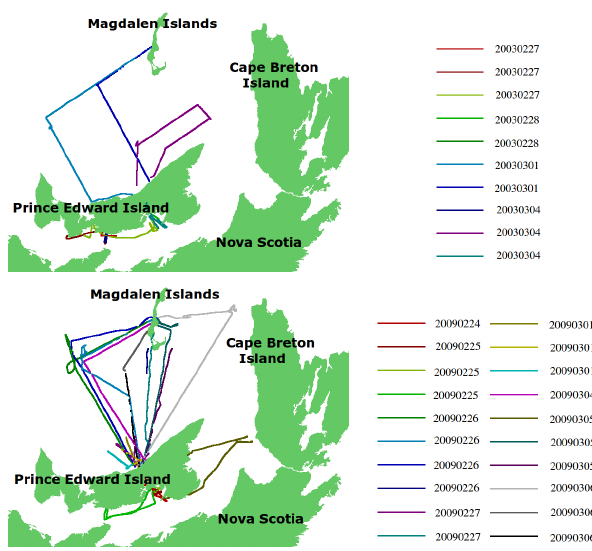
Fig. 4. The EM flights in 2003 (left) and 2009 (right). The flight dates are shown by the colors.